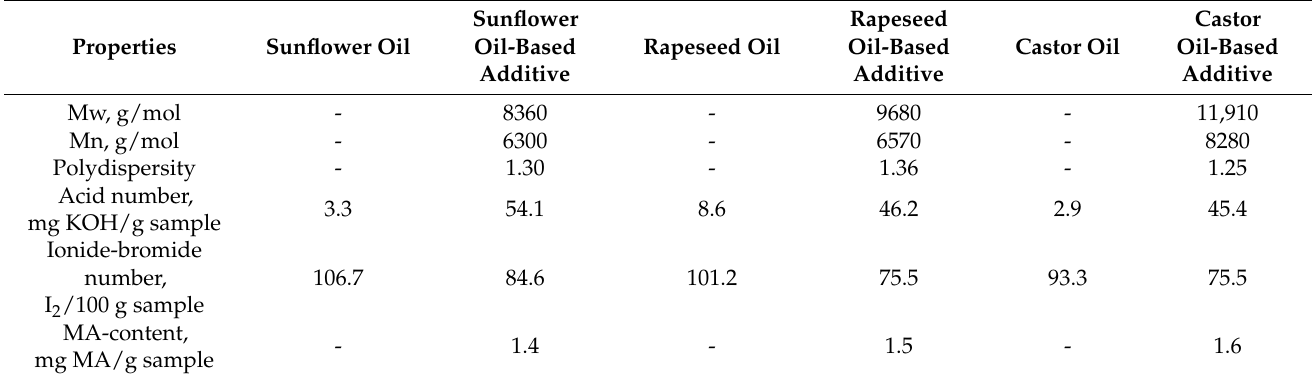
Table 1. Acid number, iodine-bromide number and MA-content values of synthesized